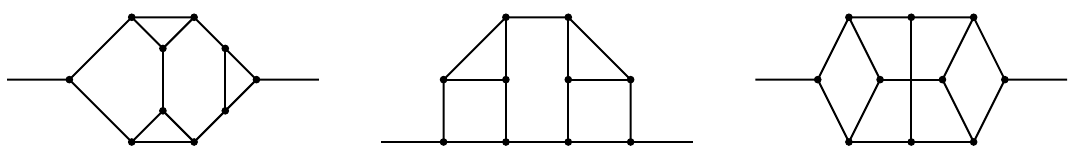
Figure 1 . These are three examples of maximal sectors for five-loop p-integrals. The diagrams have only cubic vertices and 14 internal propagators. The rightmost sector is an example of a non-planar